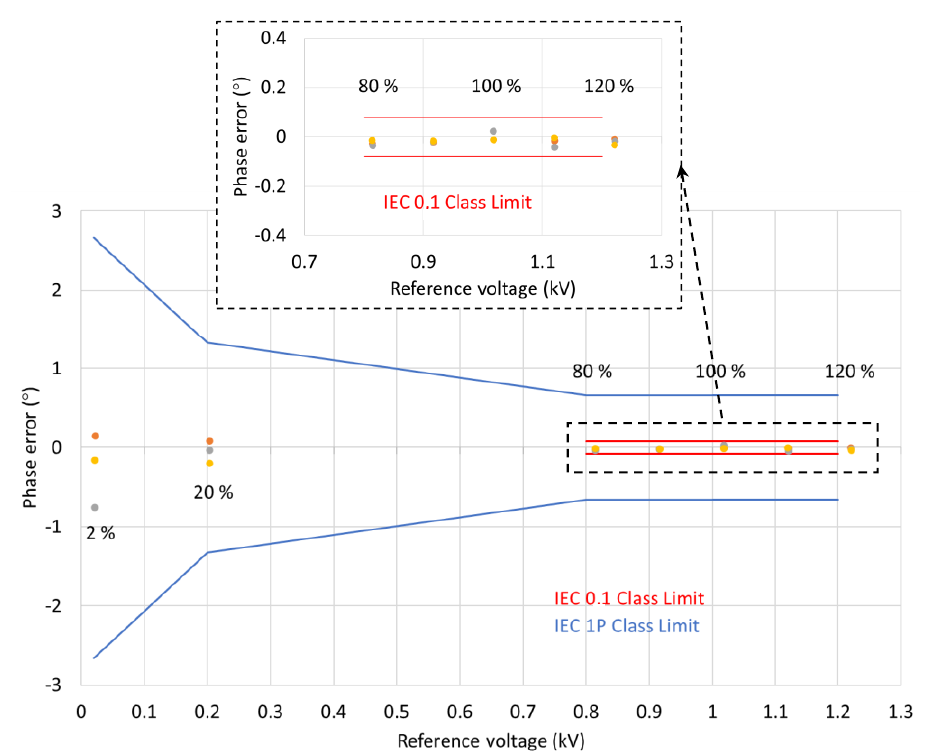
Figure 9. MVT phase errors.